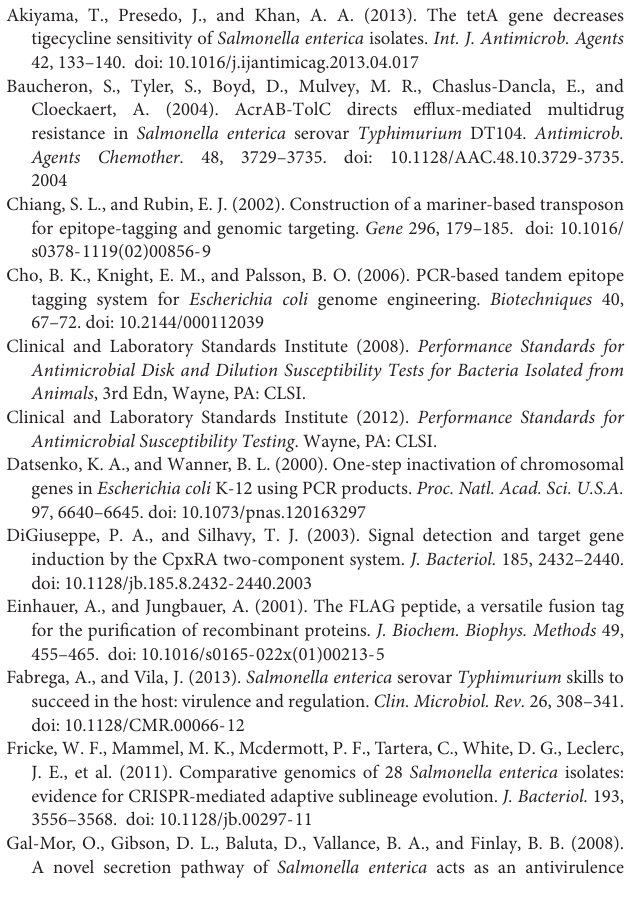
fragments were amplified by PCR with primers CpxR ∗ -F/R. Molecular size markers (DL2000 DNA marker, Takara) are indicated. FIGURE S5 | Preparation of various recombinogenic DNA of CpxA . In PCR-1, the corresponding downstream and upstream regions of various DNA modification fragments CpxA L 38 F , CpxA (cid:49) 92 − 104 and CpxA C − 3 × FLAG , were amplified by PCR using the genomic DNA of WT strain JS. 3 × FLAG, tagging the C-terminal of CpxA, was amplified by PCR using a pair of complementary oligonucleotides. UP, upstream region of the target gene to be modified. DW, downstream region of the target gene to be modified. In seamless assembly, successful assembly of corresponding PCR products were confirmed by PCR with primers CpxA-UF/DR. In PCR-2, various recombinogenic DNA fragments were amplified by PCR with primers CpxA ∗ -F/R. Molecular size markers (250 bp DNA ladder marker, Takara) are indicated. FIGURE S6 | Preparation of various recombinogenic DNA of acrB . In PCR-1, the corresponding downstream and upstream regions of various DNA modification fragments, acrB D 408 A and acrB SD were amplified by PCR using the genomic DNA of WT strain JS. UP, upstream region of the target gene to be modified. DW, downstream region of the target gene to be modified. In seamless assembly, successful assembly of corresponding PCR products were confirmed by PCR with primers acrB-UF/DR. In PCR-2, various recombinogenic DNA fragments were amplified by PCR with primers acrB ∗ -F/R. Molecular size markers (DL2000 DNA marker, Takara) are indicated. TABLE S1 | Primers used in this study. FILE S1 | Preparation of various recombinogenic DNA